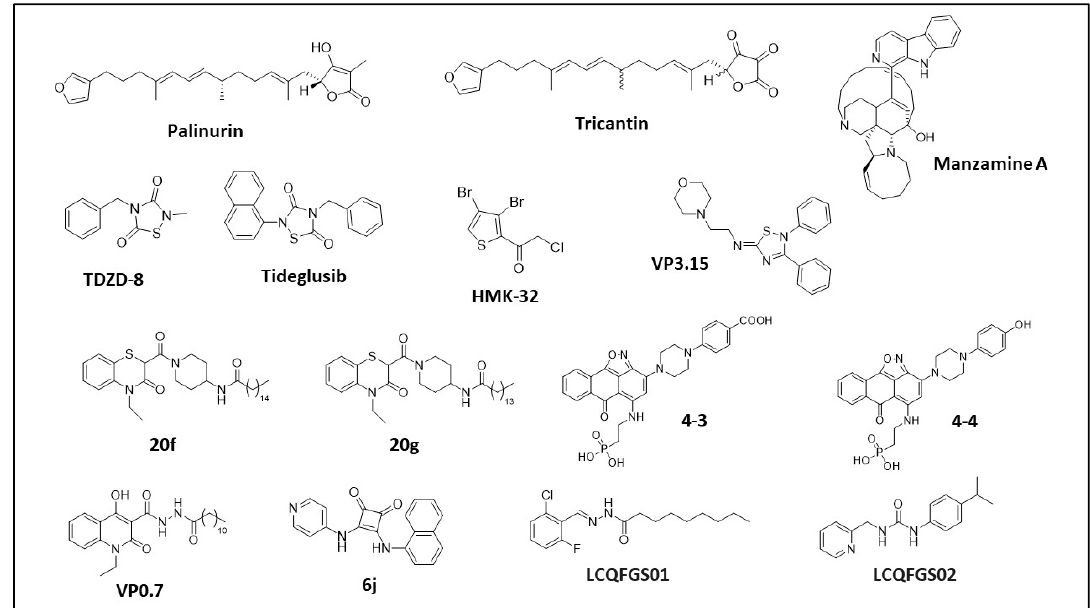
Figure 4. Structures of the available allosteric and non-ATP-competitive GSK-3 β inhibitors. Table 2. Allosteric and non-ATP-competitive GSK-3 β inhibitors.